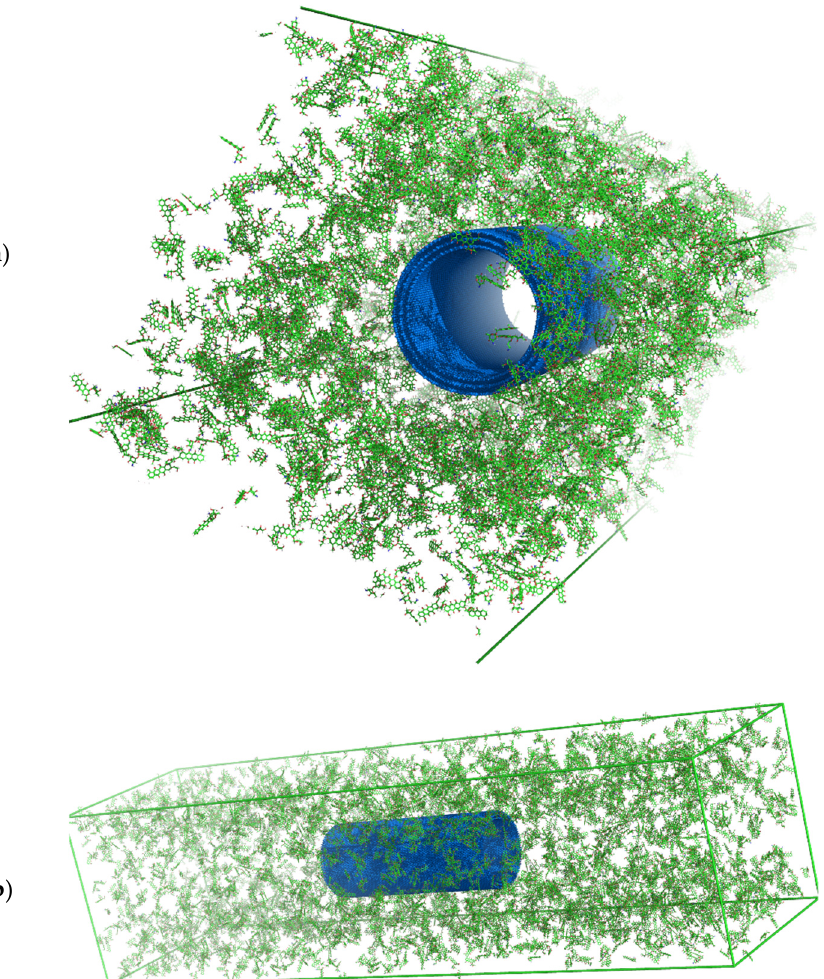
Figure 8. Snapshots of the input configuration for the in vacuo simulation step for MWCNTs (indicated in blue) with doxorubicin (DOX, molecules indicated in green/dark red elements) from two perspectives: ( a ) view to see the nanotube through; ( b ) overall view of the entire simulation box.